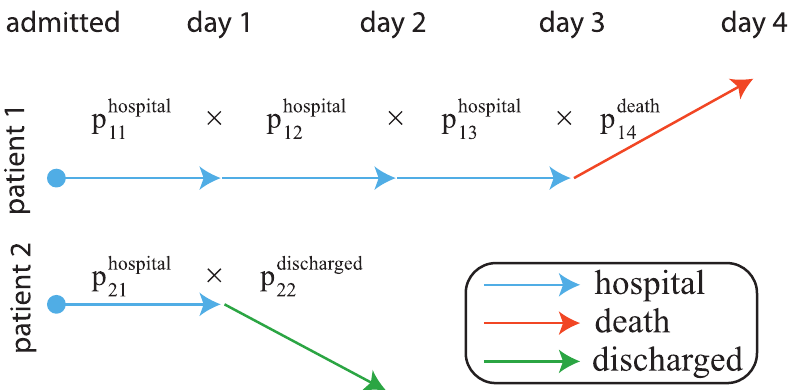
which is a function of the patient ( i ) and day ( t ): the time-dependence of probabilities is realised through Eq (2) and is due to (potential) changes in